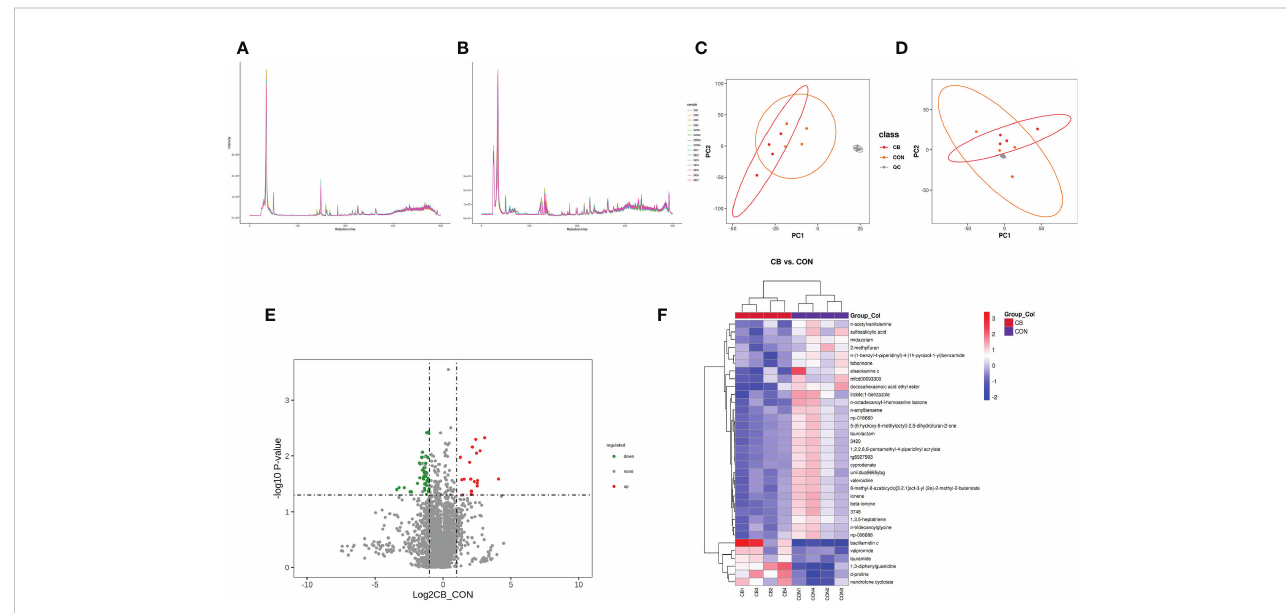
FIGURE 7 Effect of C. butyricum on blood metabolites in goats after LPS challenge. (A) Total ion chromatogram analysis chart (pos.); (B) Total ion chromatogram analysis chart (neg.); (C) PCA of the principal component (pos.); (D) PCA of the principal component (neg.); (E) Differential metabolite volcano map, the abscissa represents the difference multiple change (log2-fold change) of metabolites in different groups, and the ordinate represents the difference signi fi cance level (-log10 P -value). Each point in the volcanic map represents a metabolite, the signi fi cantly upregulated metabolites are represented by red dots, the signi fi cantly downregulated metabolites are represented by green dots; (F) Cluster analysis of differential metabolites.